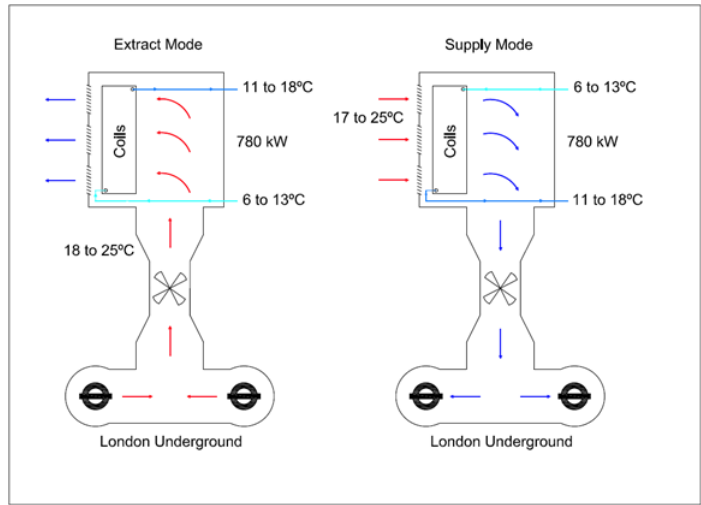
Figure 2. Schematic of the heat exchanger and the ventilation shaft of the Bunhill Energy Centre 2.